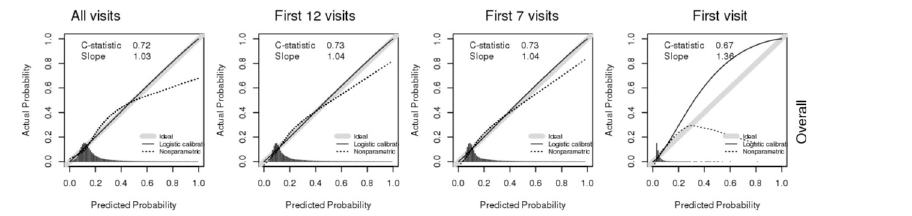
Fig 2. Model discrimination and calibration by cumulative visits.